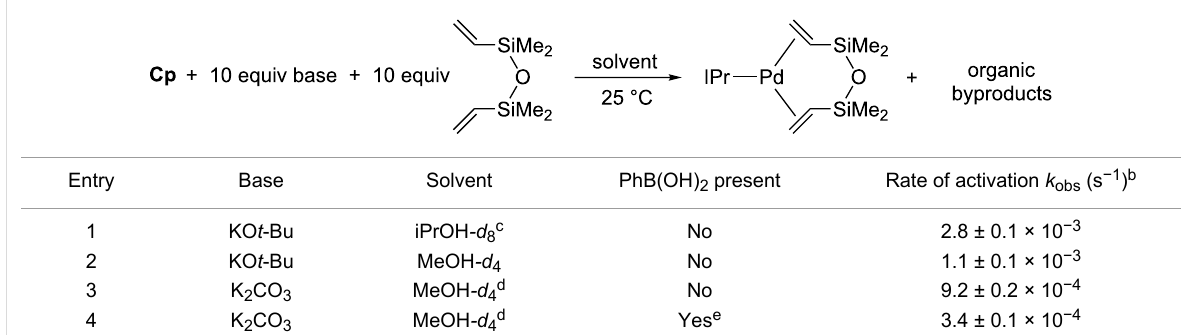
Table 1: Rates of activation of Cp under different conditions in the presence of dvds.